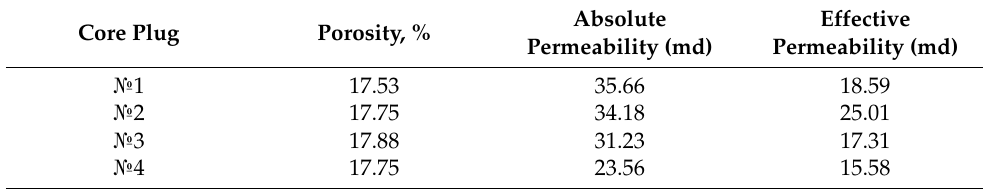
Table 2. Core plugs properties.